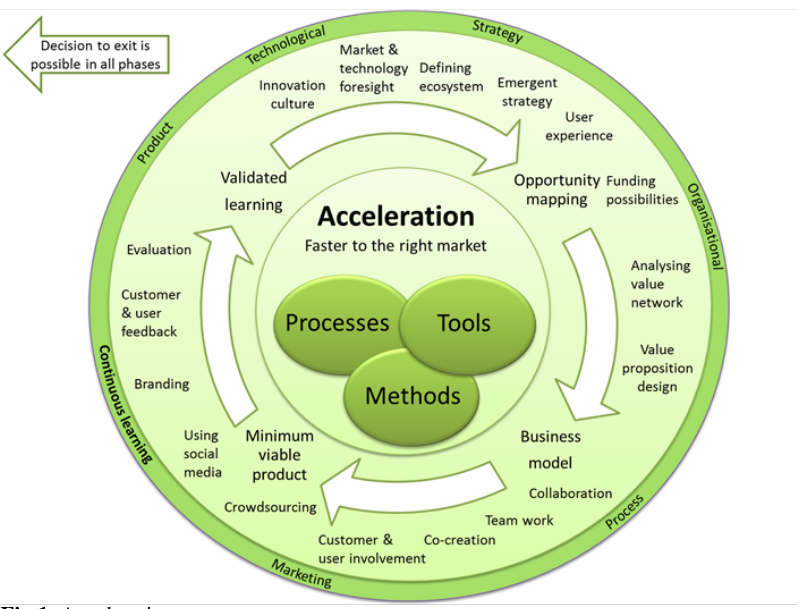
Fig 1 . Acceleration